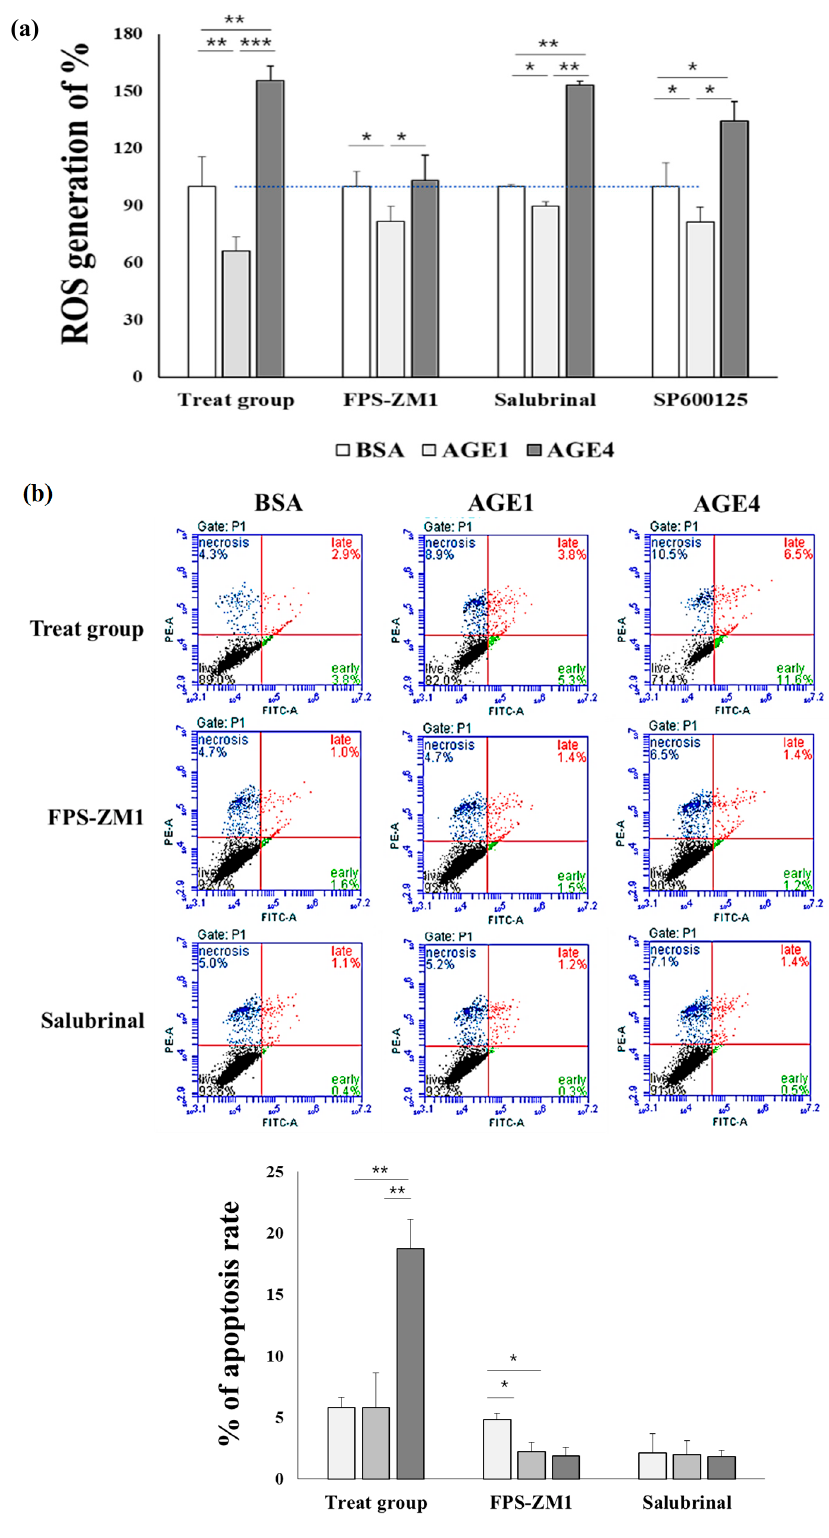
Figure 5. Effects of AGE4–RAGE axis on the reactive oxygen species (ROS) and apoptosis in HK-2 cells. HK-2 cells were pretreated for 3 h with 10 µ M FPS-ZM1 or 10 µ M salubrinal before being treated with 200 g/mL of AGE4. ( a ) The generation of ROS in response to AGE4 was assessed by DCF-DA assay. Black segment: live cells, lower-left quadrant; green segment: early apoptosis